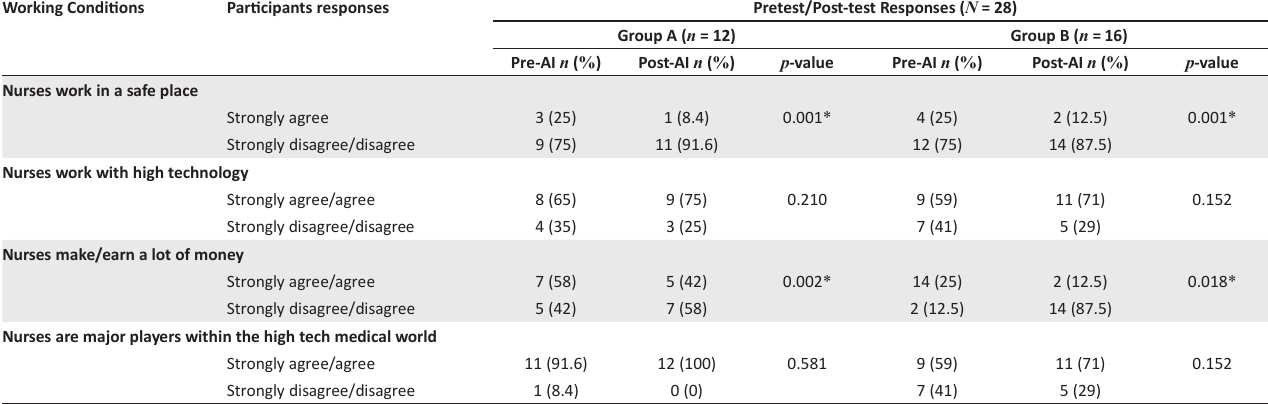
TABLE 5: Student nurses’ perceptions of the working conditions of nurses before and after AI. Working Conditions Participants